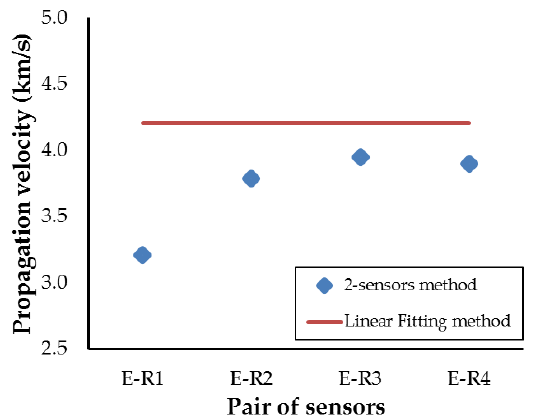
Figure 21. Elastic wave propagation velocity obtained for beam 1 using the AIC technique. In blue rhombuses: obtained individually by means of the pair sensor E-R i (i:1–4). On a horizontal line: obtained by a linear fitting.